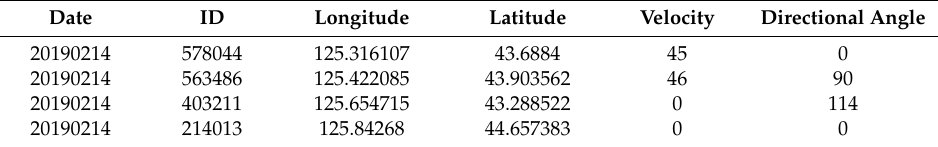
Table 1. Description of GPS data of experimental vehicles from February 14 to February 15.